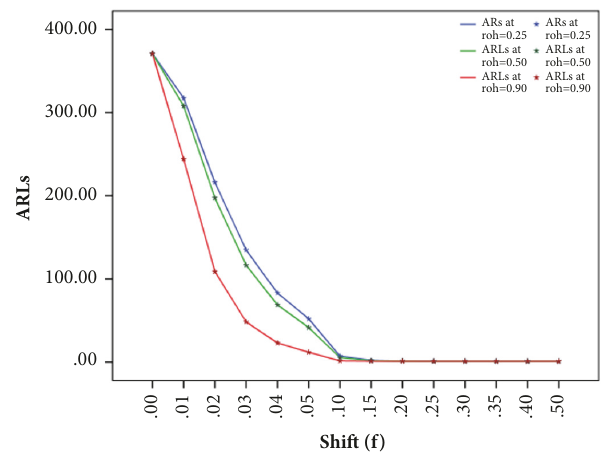
Figure 4: For proposed repetitive EWMA-RSS control chart using Bahl and Tuteja (1991) ratio estimator, when 𝑟 𝑜 = 370 at 𝜆 = 0.1.